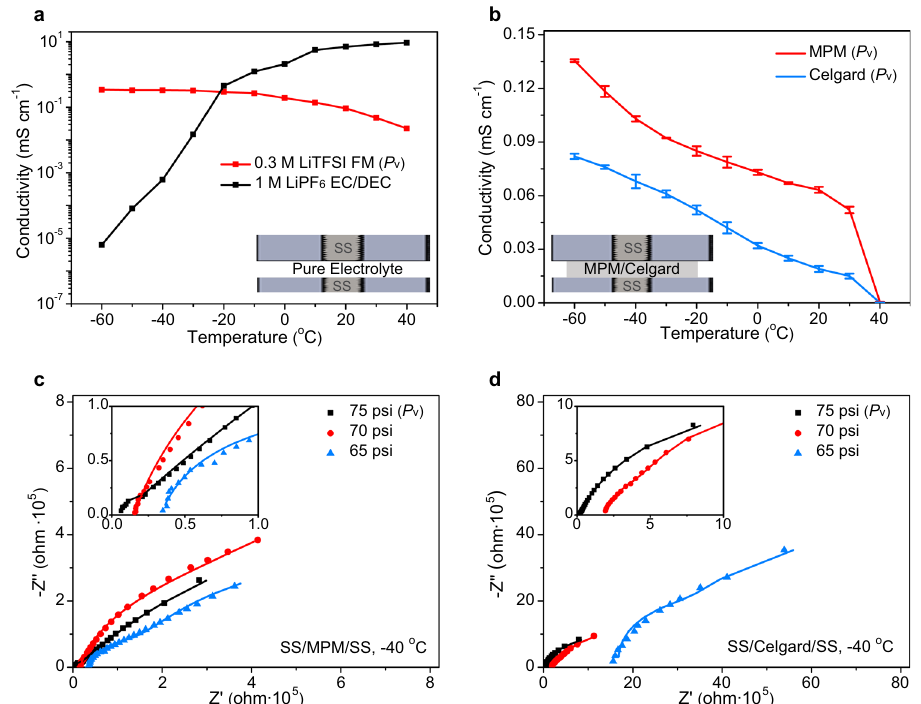
Fig. 4 Electrochemical properties of MPM-based LGE. a Ionic conductivity of pure electrolyte with LGE or conventional liquid electrolytes. b Ionic conductivity of LGE with the presence of MPM or Celgard-based membranes as the separator at different temperatures. The two symmetric stainless-steel (SS) cells shown in the inset a and b were set to remain the consistent 500-micron distance. Nyquist impedance of cells with MPM ( c ) or Celgard-based ( d ) membrane as the separator at − 40 °C and different FM